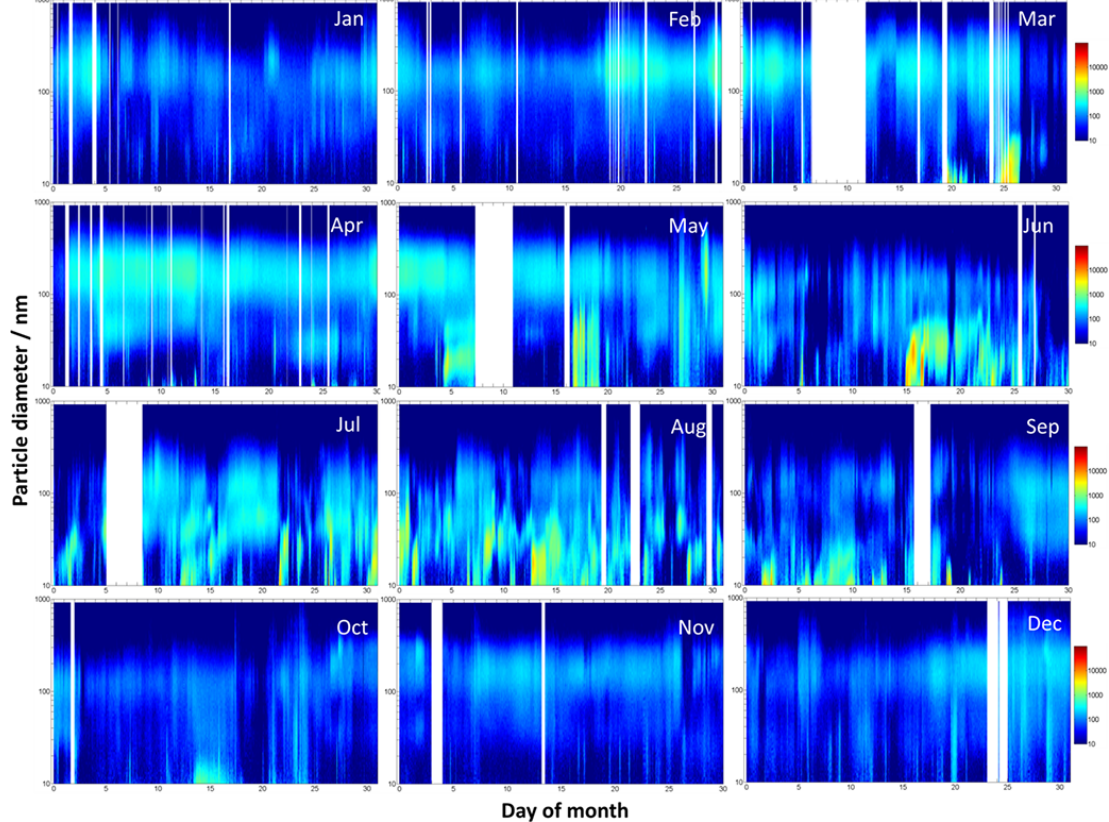
Figure 3. Time series of particle number size distributions as d N/ dlog D p (cm − 3 ) during 2012. The original 5min time resolution was used in the